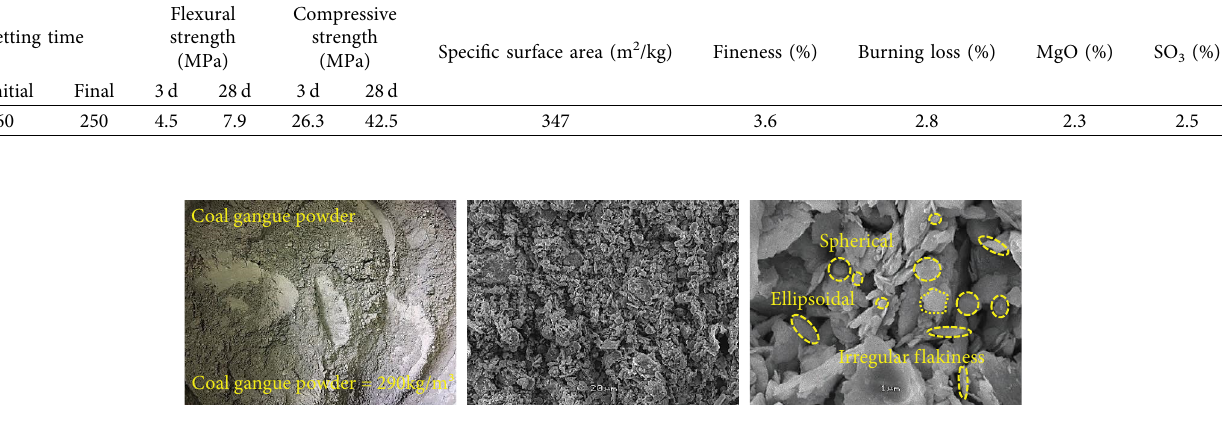
Figure 2: Te morphology and microstructure of coal gangue powder.